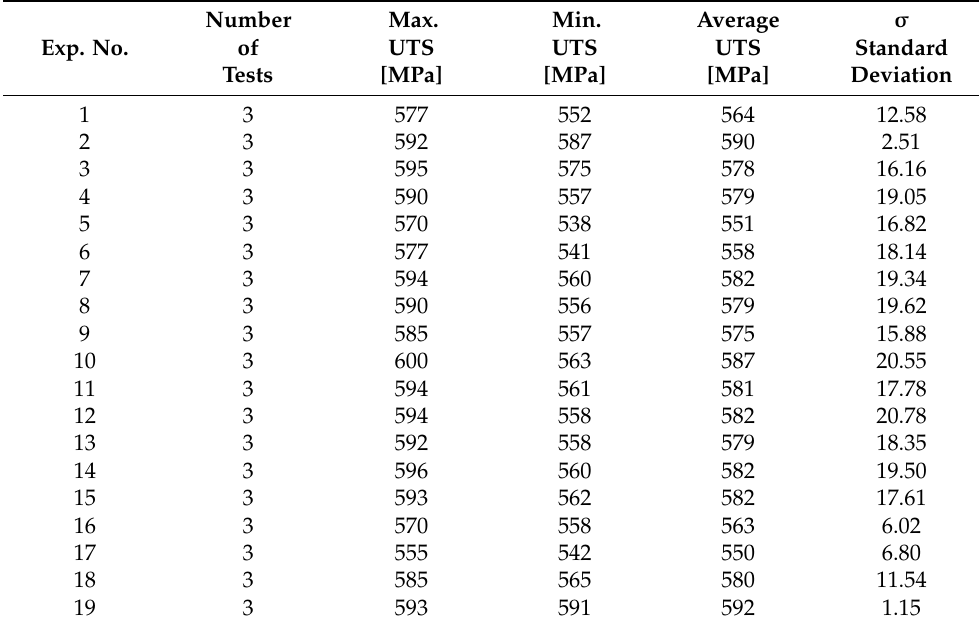
Table 5. UTS of a set of experiments with the different combinations and the related standard deviation σ